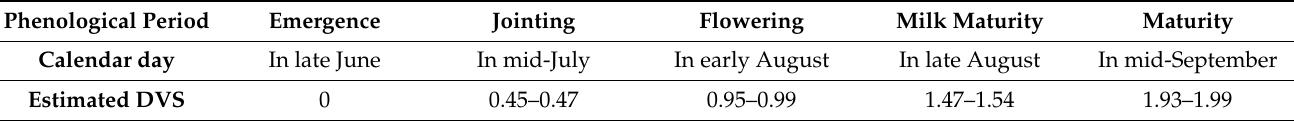
Table 4. Refinement Results of DVS Based on Effective Accumulated Temperature Threshold.